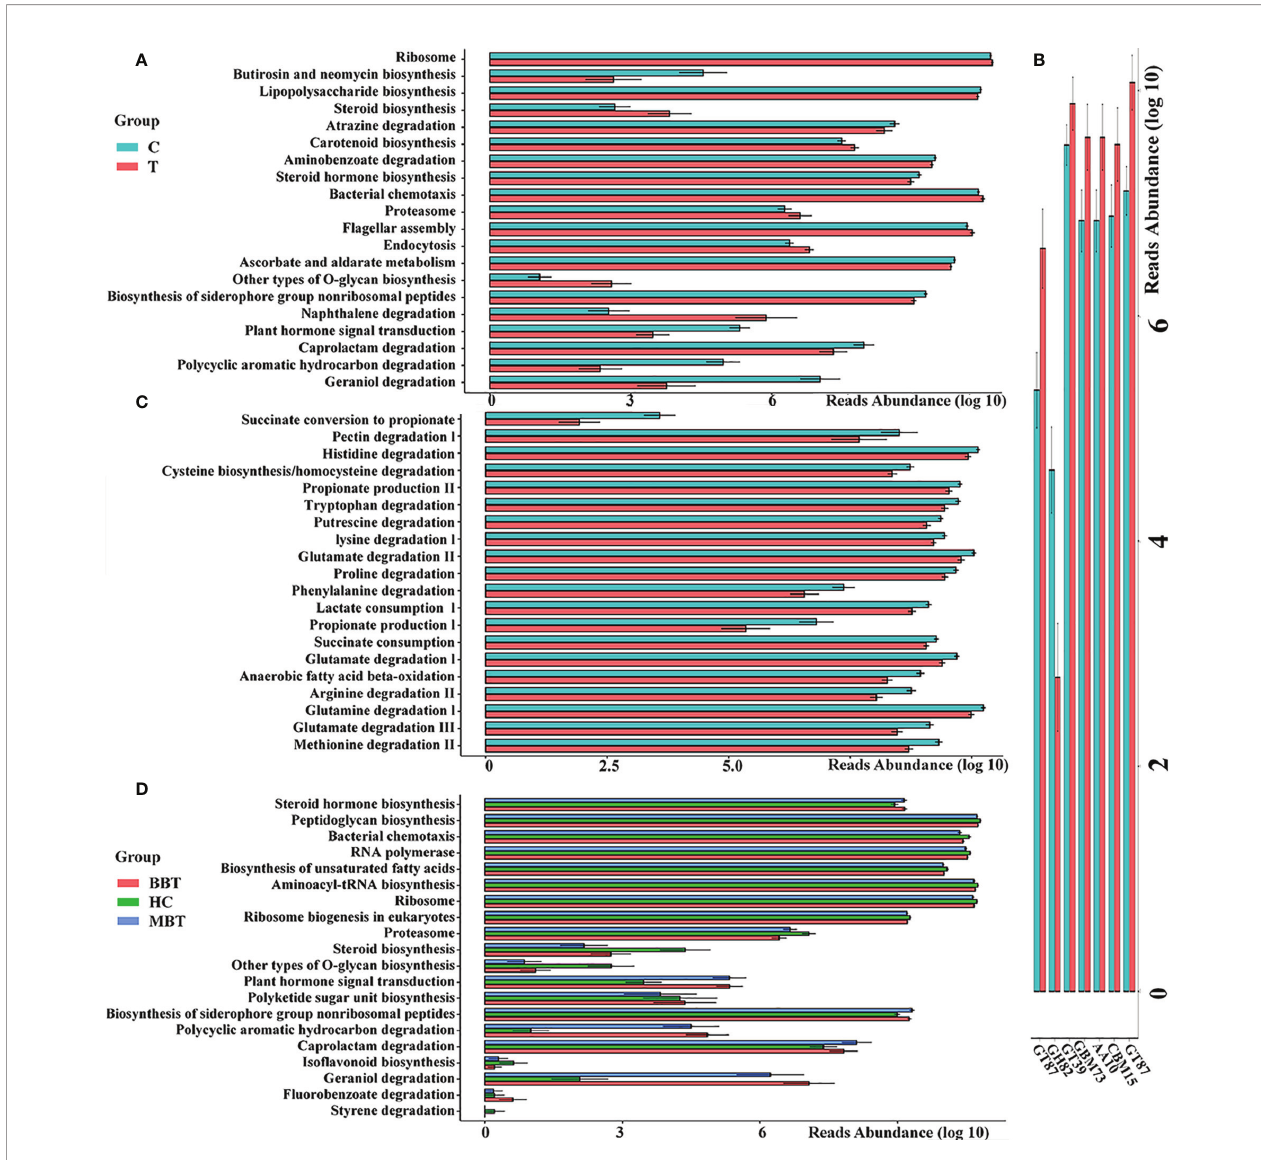
FIGURE 5 | Predicted metagenome function of gut microbiota between different groups. PICRUSt built-in database and Carbohydrate-Active enZYmes (CAZy) Database were referenced to evaluate different bacterial functions in the brain tumours and the healthy groups. Comparisons between the groups for the most twenty signi fi cantly different KEGG pathways (A) and seven Carbohydrate-active enzymes (CAZy, B ) are displayed. The gut metabolic modules of KEGG pathways (C) . The subgroup analysis of KEGG pathways (D) . All the differences in this graph show a p value less than